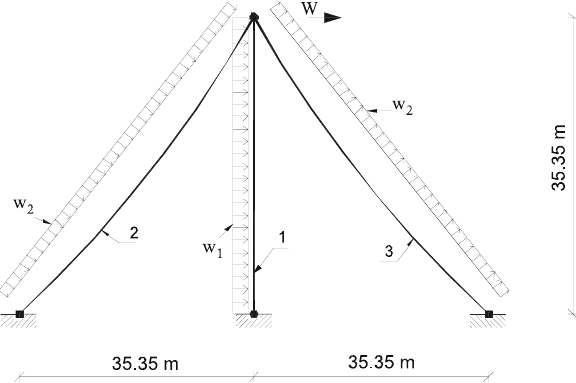
Fig. 1. Design model for mast numerical experiment A sufficiently large range of pre-stressing force 01102 ..H ÷= kN was chosen for numerical simula- 0 m tions. During experiment the mounting and exploitative mast states were considered. The internal forces of mast structural elements and mast stem (pole) displacements were